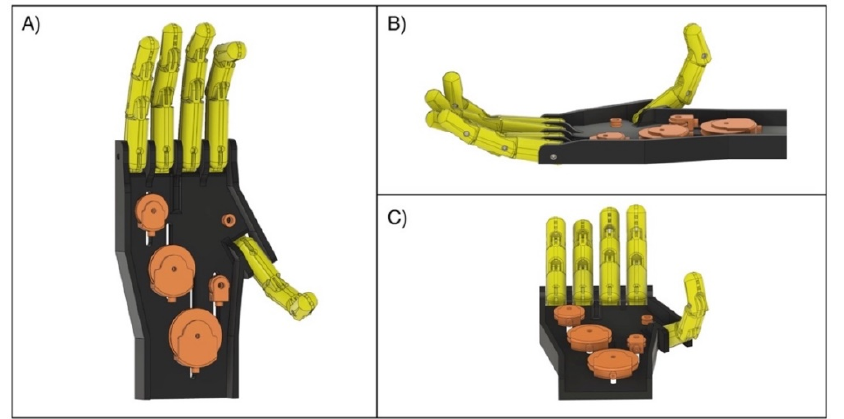
Figure 1. 3D renderings of the “Federica” prosthetic hand: ( A ) Top view; ( B ) Side view; ( C ) Bottom view.